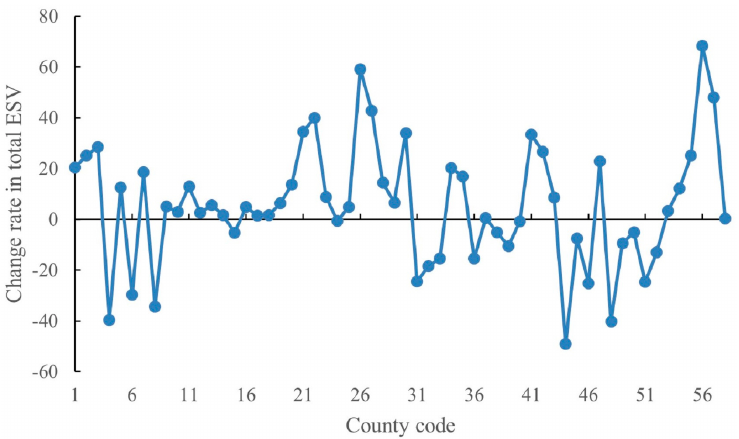
Figure 7. Change rate of total ESV of study area at county scale from 2015 to 2020.